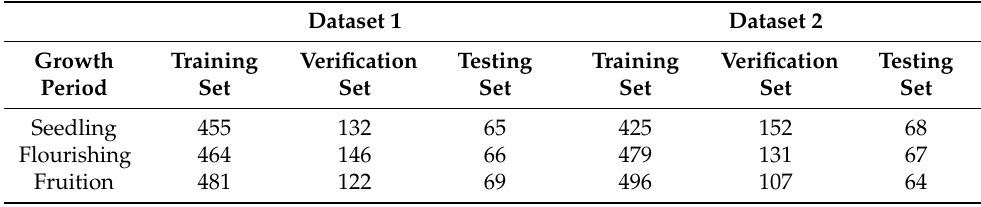
Table 2. Image distribution of citrus crown after data